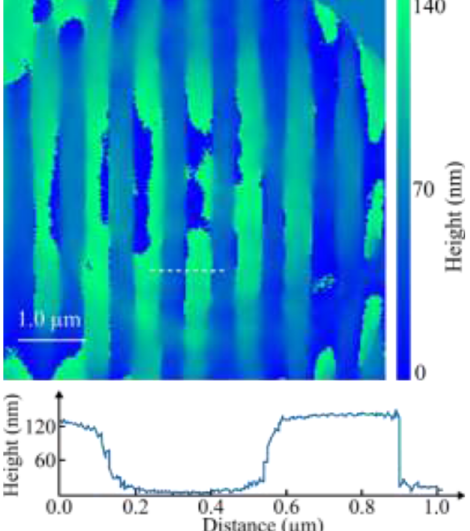
Fig. 1. Topography reconstruction of an 800-nm-period standard grating using microsphere-assisted interference microscopy compensated by two 50-μm-diameter microspheres. The height profile is along the dashed-white line of the high-resolution surface-topography